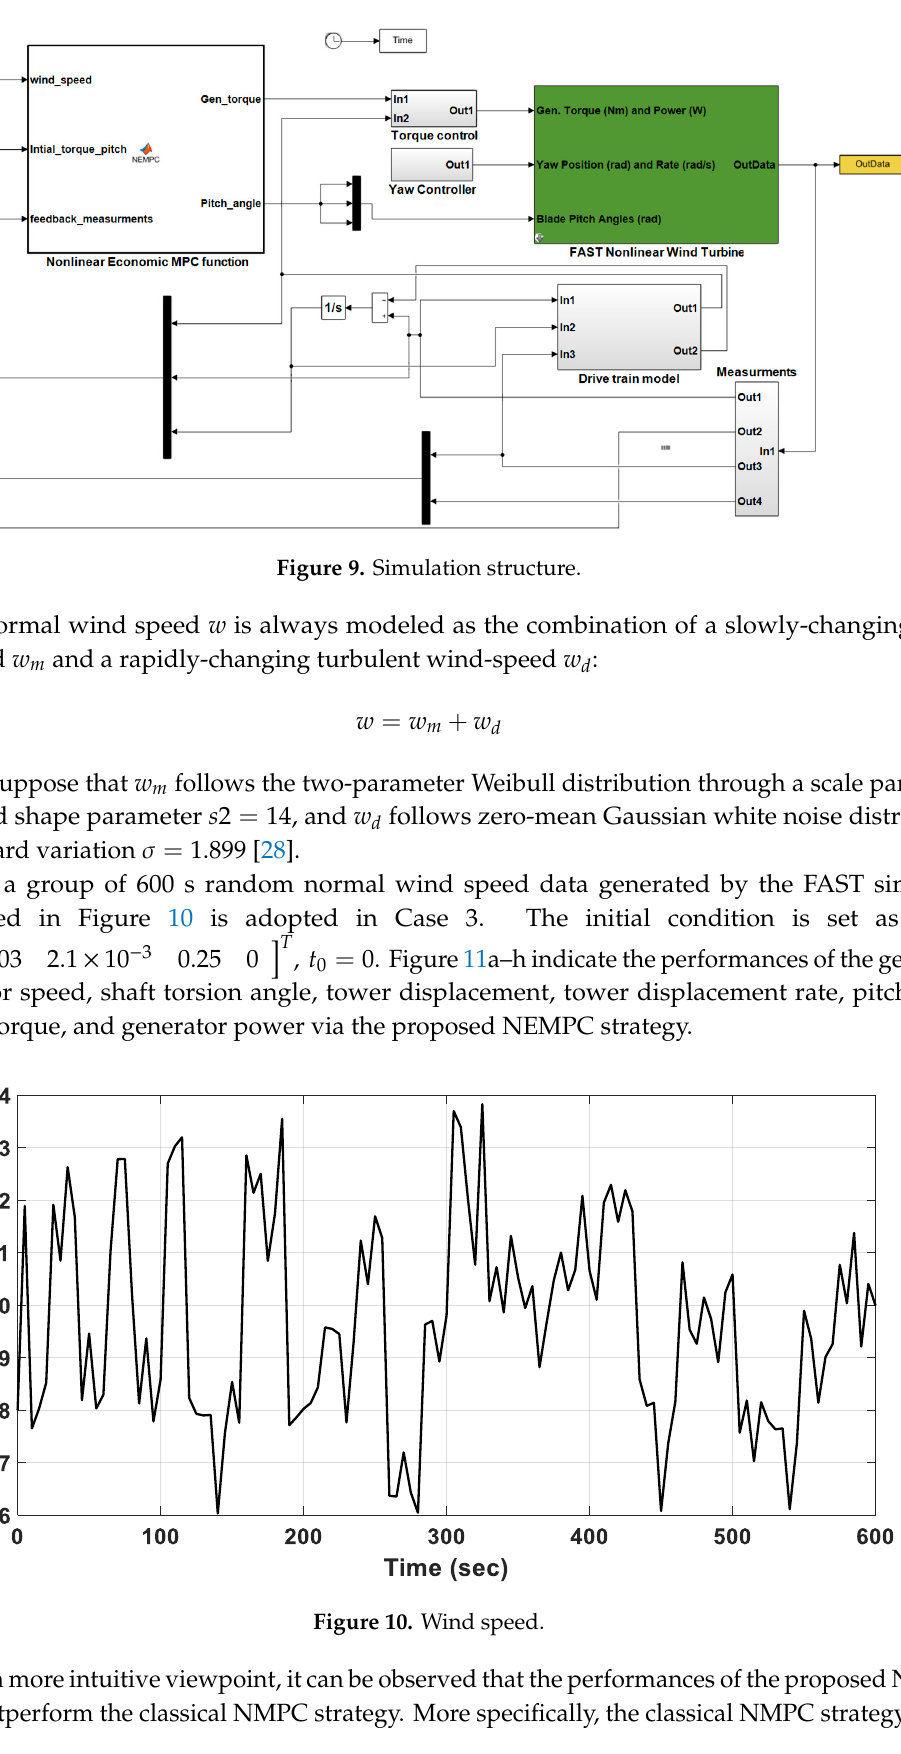
Figure 8. The FAST S-Function Block.